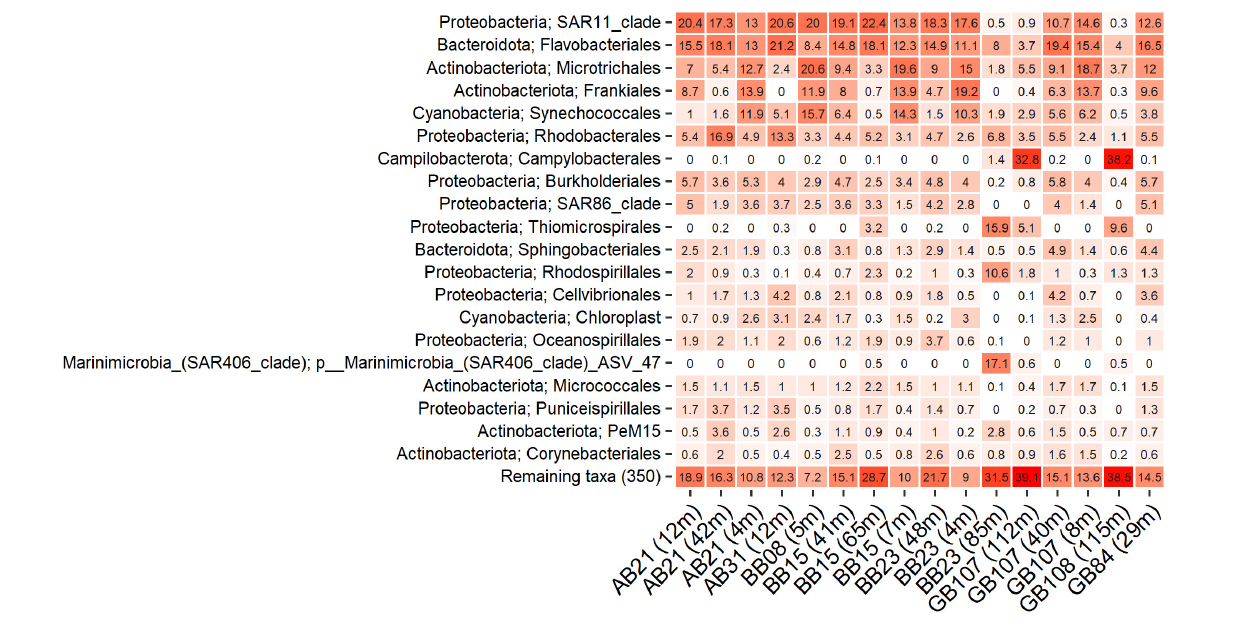
FIGURE 2 | Percentage of relative abundance based on depth-wise stations of microbial order at three basins in the Baltic Sea. TABLE 2 | Physical factors and bacterial diversity estimates for water collected from three basins in the Baltic